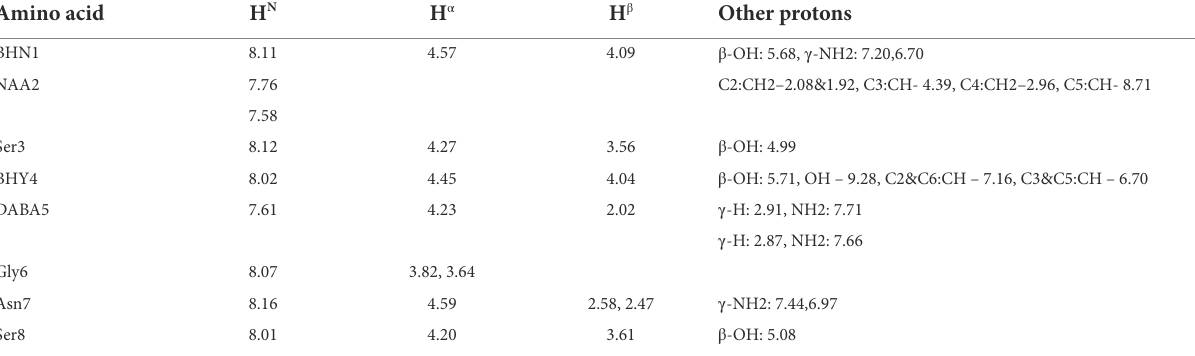
TABLE 1 NMR chemical shifts for aldehyde analog of occidiofungin.